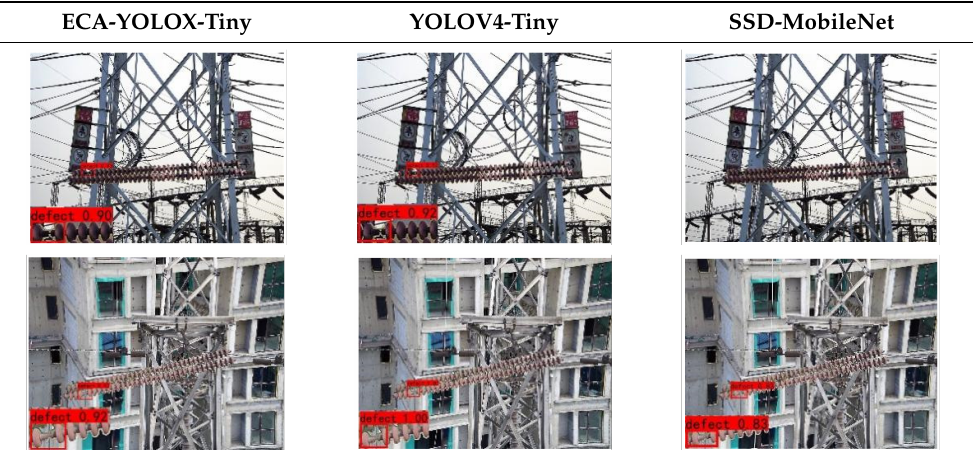
Table 8. The detection effect of different models for defective insulators with complex